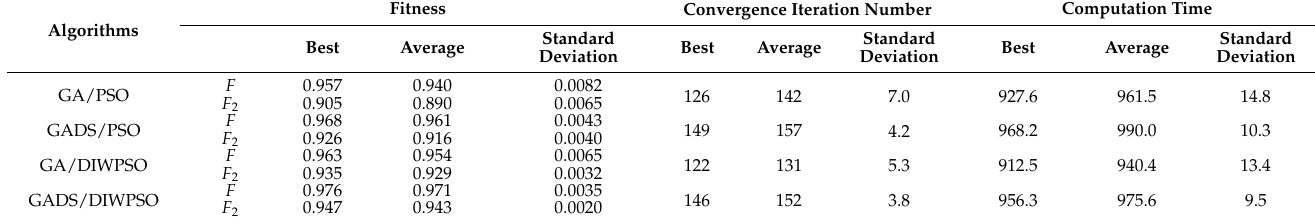
Table 11. Algorithm comparison results.